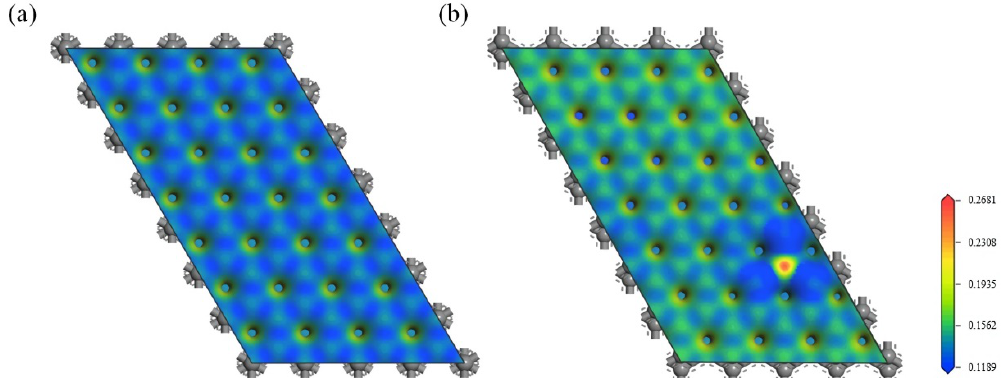
Figure 7. Electrostatic surface potential mapping within the (001) plane of ( a ) graphite and ( b ) boron-doped graphite across the boron atoms visualized using a chromatic scale from red (positive ESP) to blue (neutral ESP). The unit of ESP is Ha e −1 .